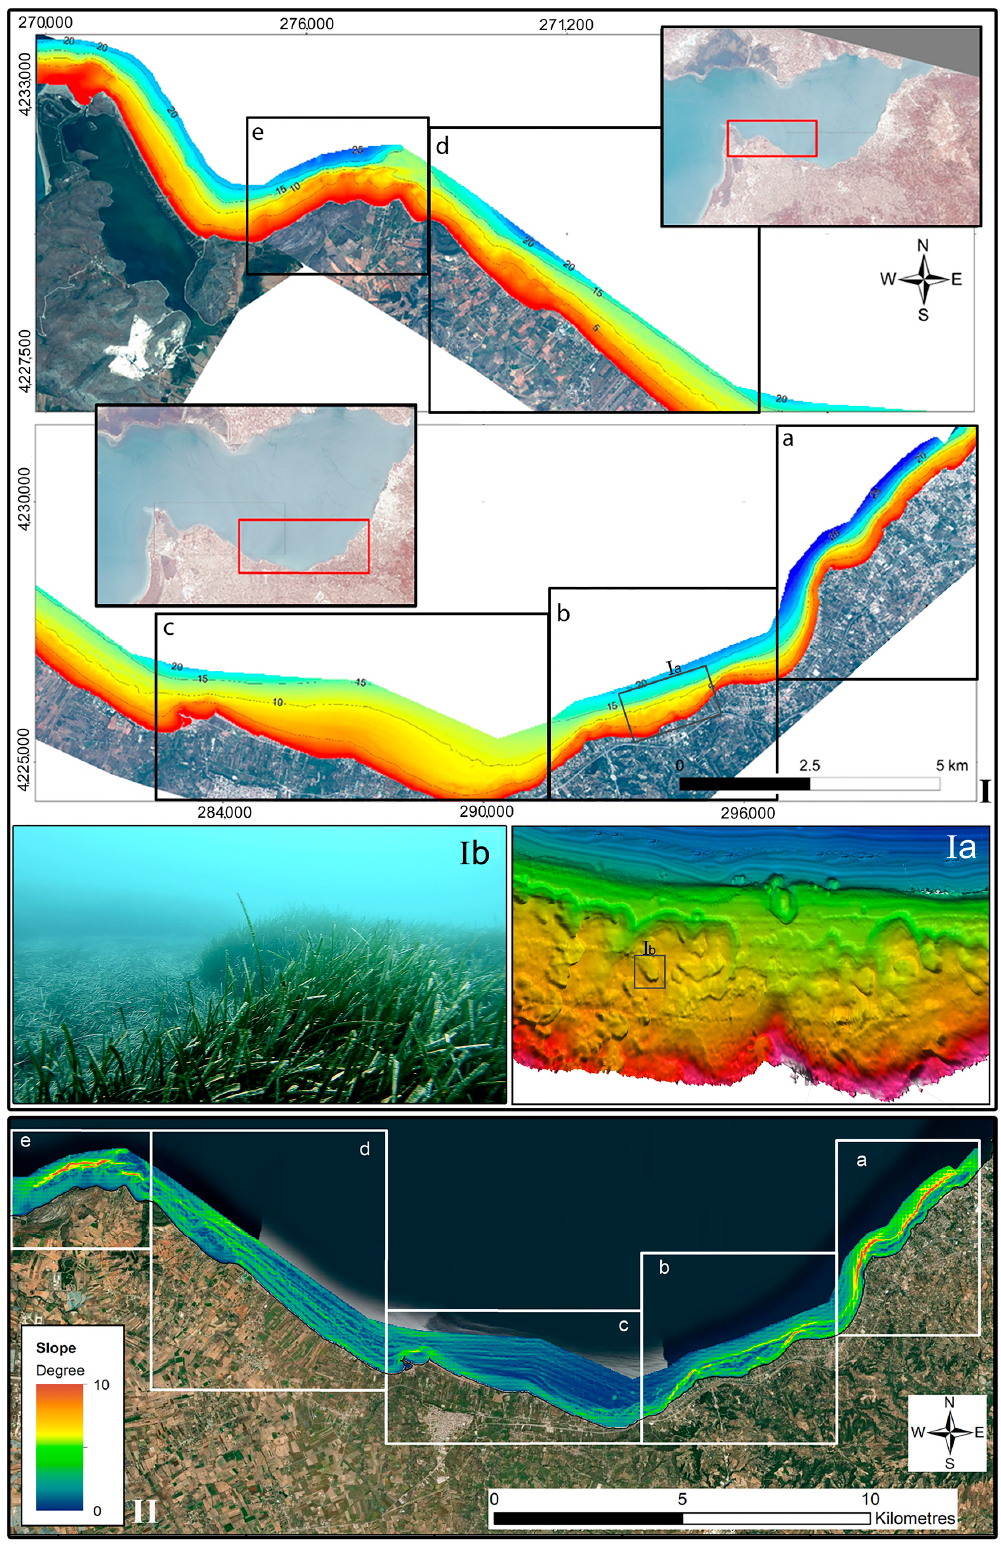
Figure 13. ( I ) Bathymetric map of the survey area. ( Ia ) Detailed bathymetry showing P. oceanica meadow morphology and ( Ib ) underwater photo of P. oceanica . ( II ) Slope gradient map of the survey area. Based on the multibeam bathymetric data and the slope gradient, the area has been separated into five (a–e)